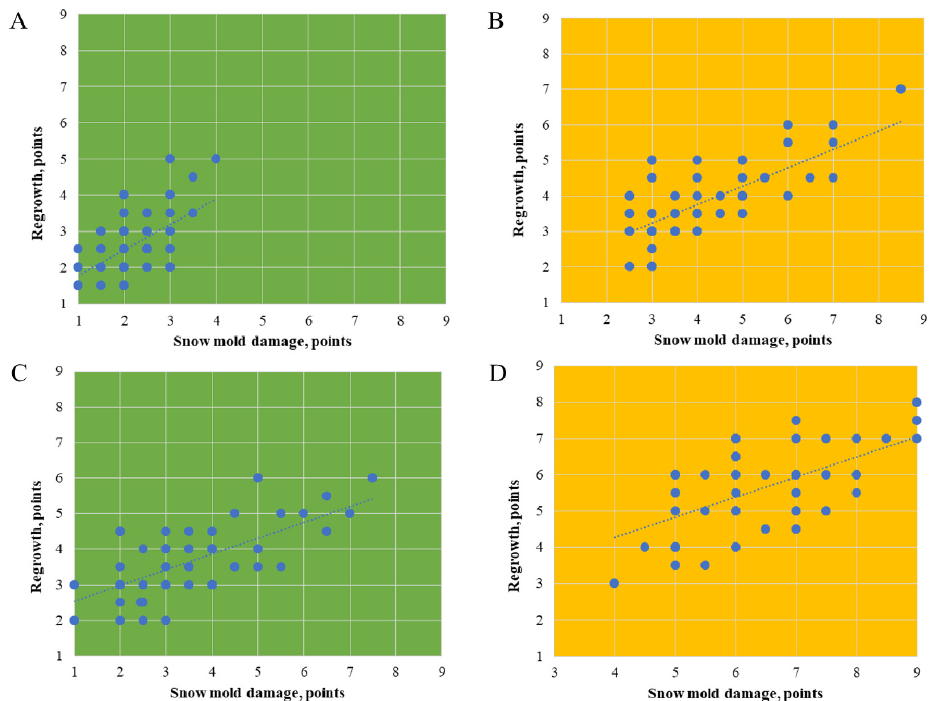
Figure 3. Correlation between snow mold disease scores assessed within a week after the snow melt (evaluation 1) and two weeks after the evaluation 1 (evaluation 2) on 58 rye accessions; evaluation 2 shows plant regrowth ability after the snow mold damage. The evaluations were performed in 2020 ( A , B ) and 2021 ( C , D ) under a natural infection background (green, A , C ) and an artificially-enriched infection background (yellow, B , D ).